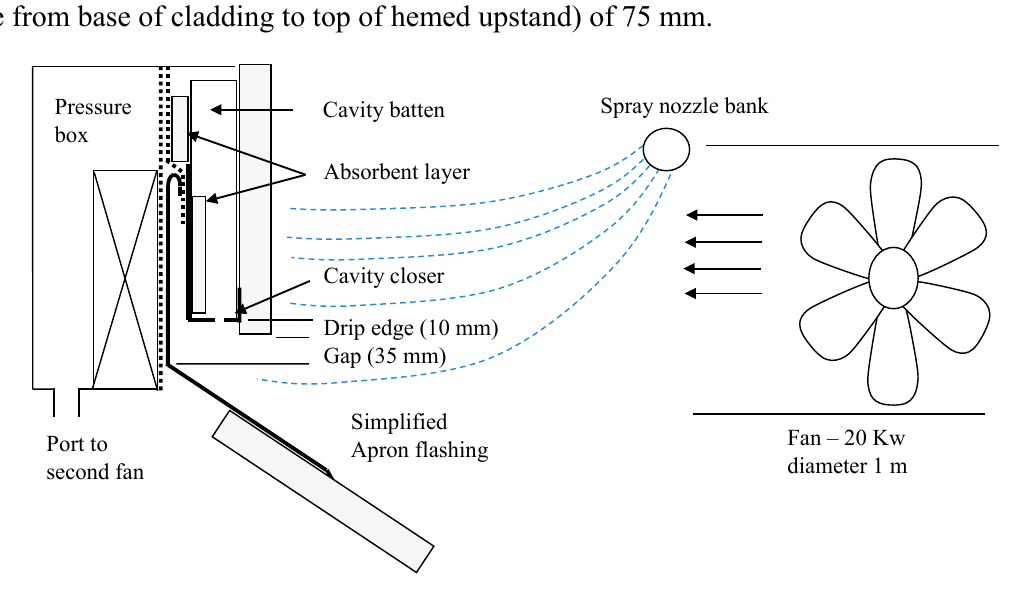
Figure 15. Experimental apron flashing joint between